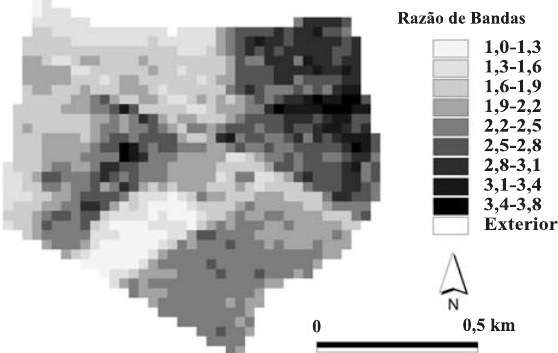
Figura 4. Distribuição espacial do valor da razão de bandas espectrais (RB) na gleba estudada (ver equação